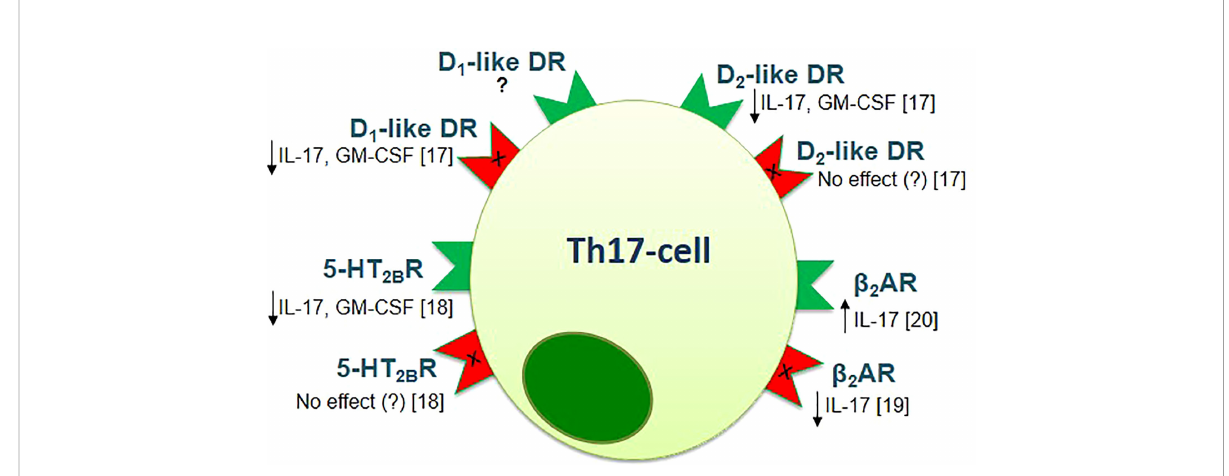
FIGURE 1 The effect of activation (green) or blockade (red) of biogenic amine receptors on the function of human Th17-cells [adapted from Melnikov et al., 2021 (20)]. Data obtained from the anti-CD3/CD28-activated puri fi ed CD4+ T-cells of patients with relapsing-remitting MS and healthy subjects [Melnikov et al., 2022 (17); Sviridova et al., 2021 (18); Melnikov, Rogovskii et al., 2022 (19)] or from the anti-CD3/CD28-activated PBMCs or puri fi ed CD3+CD4+CCR6+ Th17-cells of healthy subjects [Carvajal Gonczi et al., 2017 (21)]. D1- or D2-like DR, D1- or D2-like dopaminergic receptor; 5-HT2BR, 5-hydroxytryptamine receptor 2B; b 2AR, b 2-adrenergic